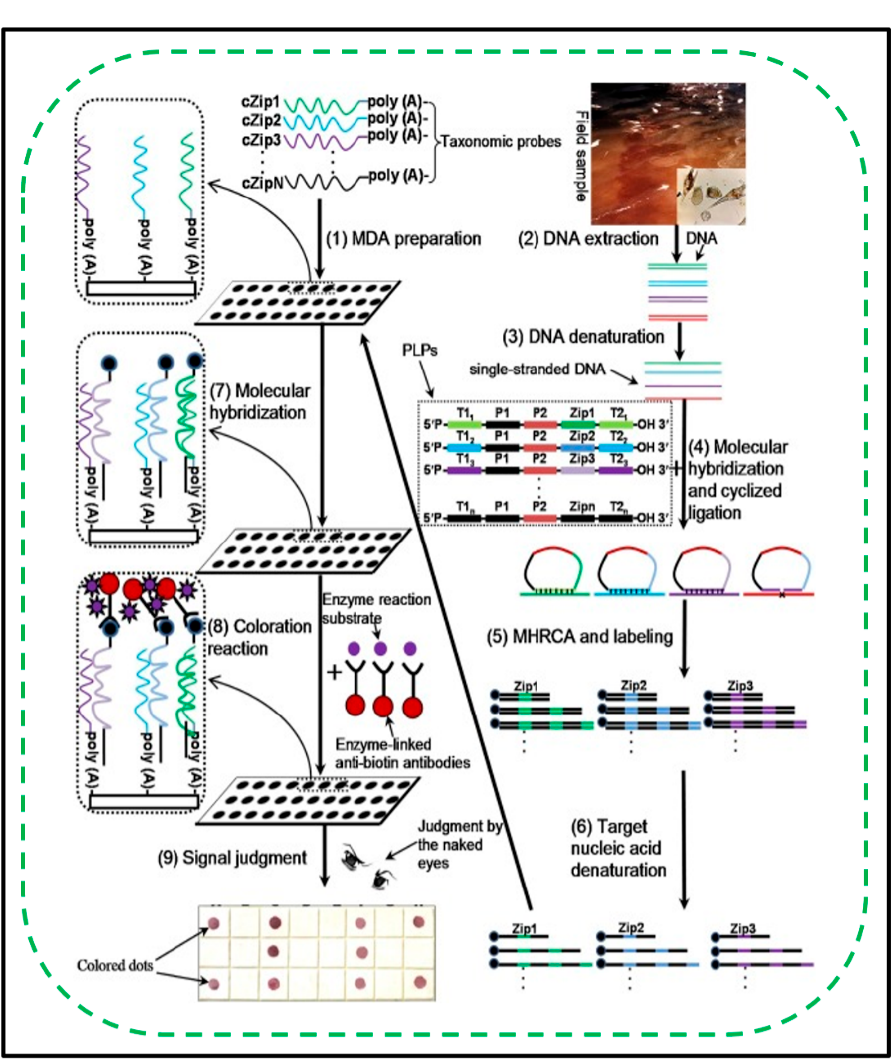
Figure 6. RCA assay for microorganism detection. Adapted with permission from ref. [92]. Pearson et al. proposed the view that “virus recombination leads to fuzzy classifica- tion” [96]. The structural composition and dynamic changes of biological communities are inevitable research fields, especially in the application of agricultural sites. Research on microbial communities with high economic attributes and related maintenance is increas- ingly being discussed. The wastewater treatment plant is a melting pot with multiple co- existences. First, its sources are relatively wide, including not only domestic wastewater, livestock and poultry breeding wastewater but also various environmental wastewaters with stress factors, making wastewater treatment plants a variety of virus libraries of hosts that can be infected. In addition, the dynamic changes of its internal environment cannot be ignored; that is, the phenomenon of virus recombination cannot be ignored. They used a combination of sucrose gradient size selection and RCA to isolate the full-length genome of the circular ssDNA virus from the wastewater treatment facility and sequenced it on Illumina MSeq to achieve virus collection inspection. However, compared with the rela- tively large dsDNA viruses that are often studied, single-stranded DNA viruses are the least known microbial pathogens, and they also face technical bottlenecks such as genome bias and difficulty in cultivation. The team studied several typical examples, including